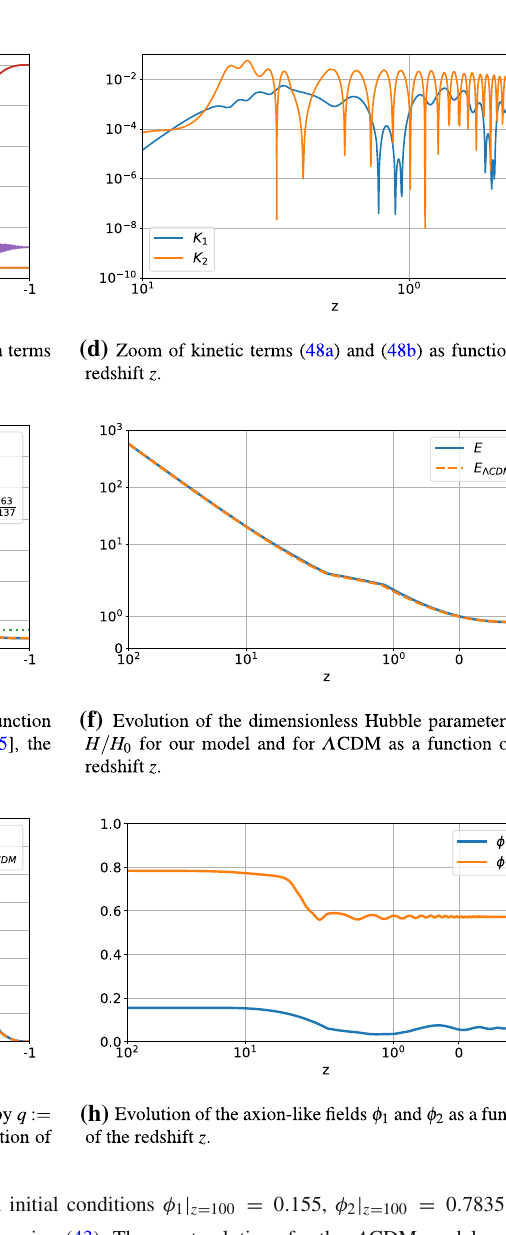
Λ CDM model are superimposed for a